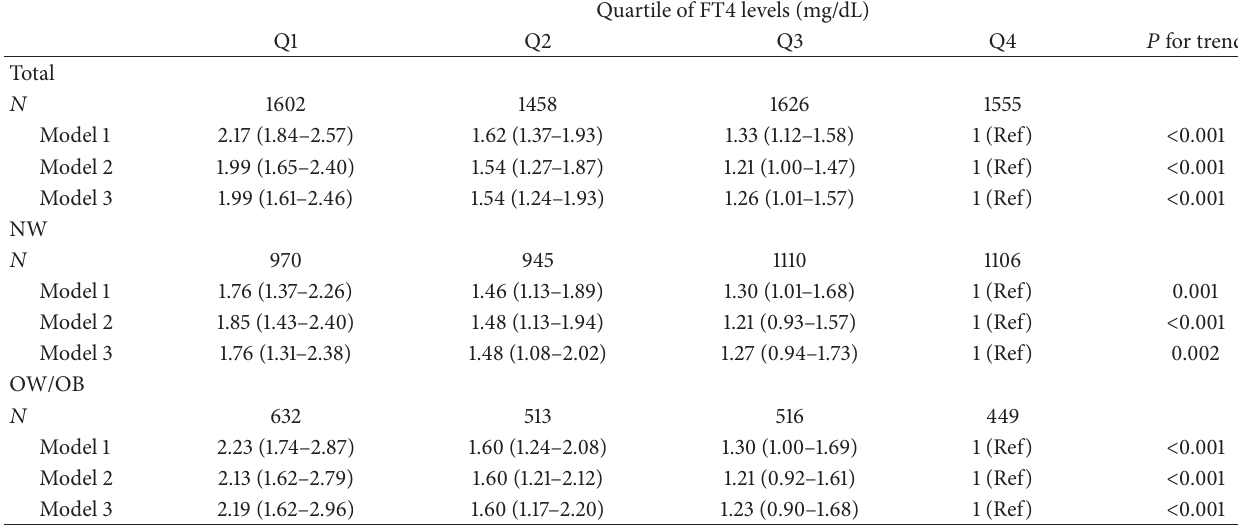
Table 4: Adjusted odd ratios (ORs) and 95% confidence intervals (CIs) for insulin resistance according to FT4